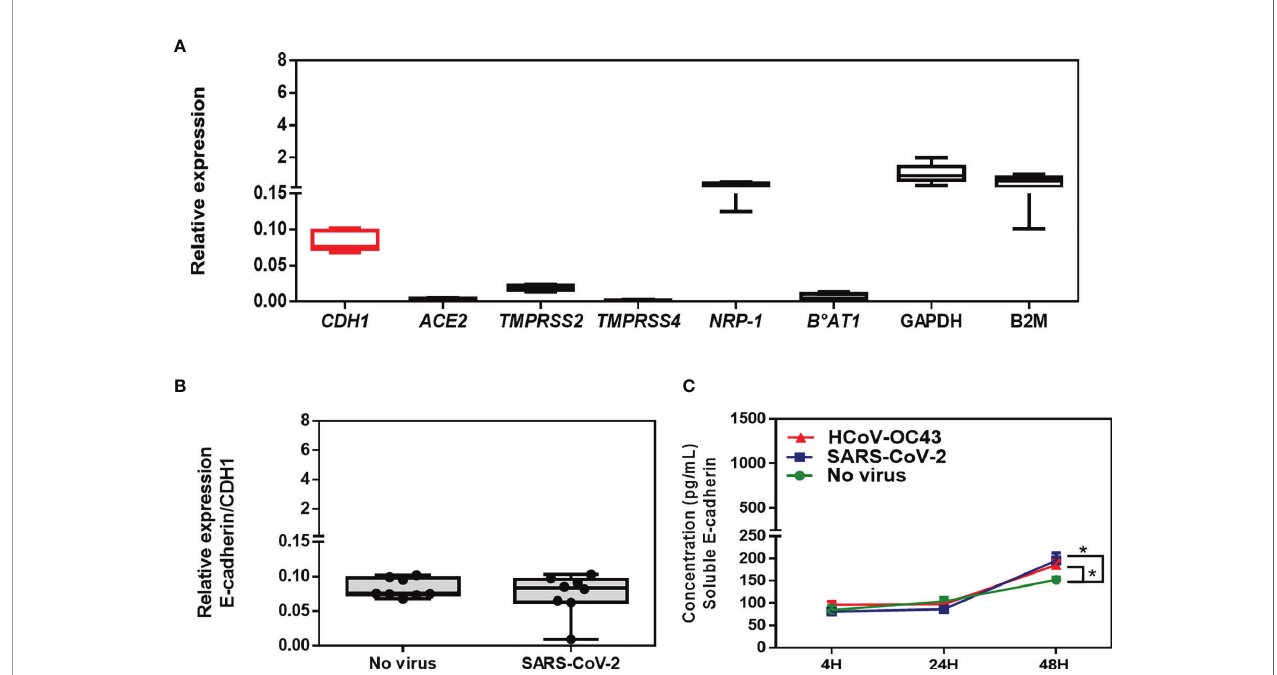
FIGURE 7 | (A) Expression of CDH1/E-Cad, ACE2, TMPRSS2, TMPRSS4, NRP-1, B 0 AT1, GAPDH, and B2M mRNA in virus-free HT29 cells. The results (n=8) are expressed as RE where RE = 2 ( − D CT) . (B) Expression of CDH1/E-cad mRNA in virus-free HT29 cells or cells exposed to SARS-CoV-2 at an MOI of 0.5 for 24 hours.